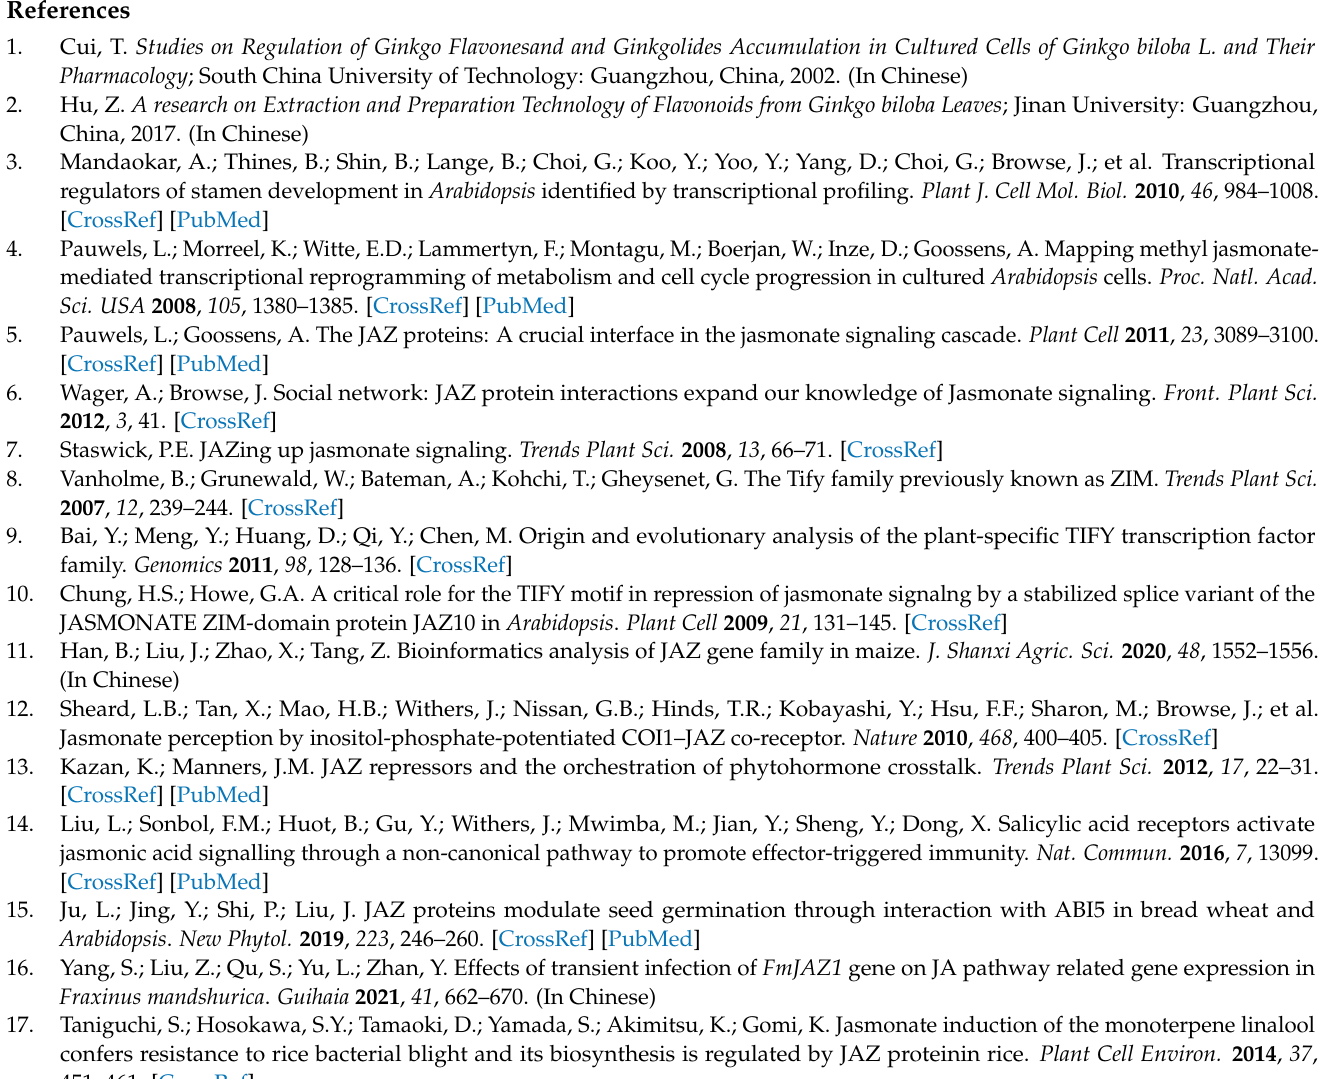
motifs; Table S1: The sequences of candidate GbJAZs; Table S2: The physicochemical properties of GbJAZs proteins; Table S3: The cis-acting elements of GbJAZs; Table S4: The sequences of JAZs in a phylogenetic tree; Table S5: The expression data statistics of GbJAZs after hormone treatment; Table S6: The data of TTL content determination; Table S7: The data of correlation analysis between the expression levels of GbJAZs and TTL content in G. biloba